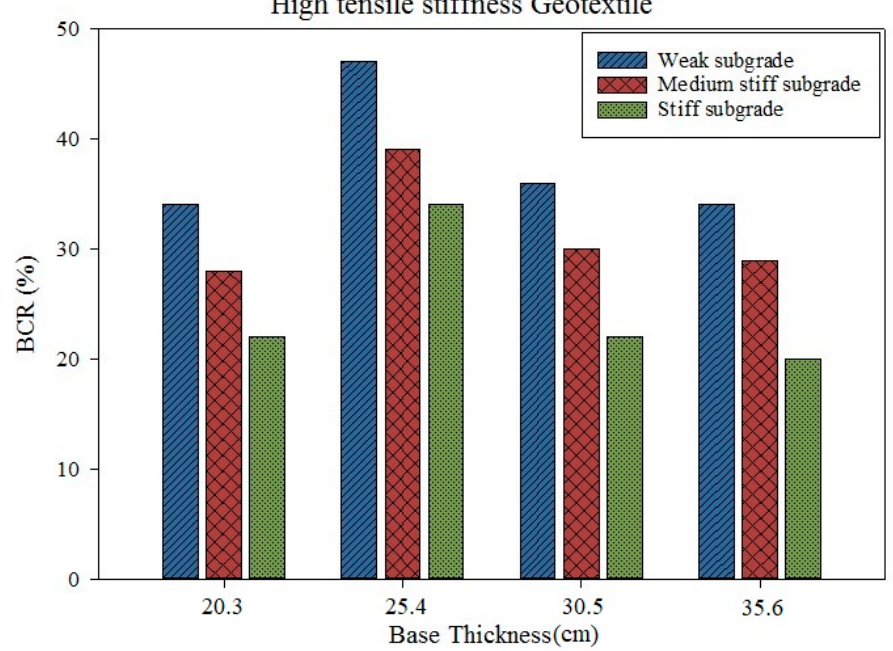
Figure 15. Changes in the BCR of the pavement reinforced with a high tensile stiffness geotextile for different subgrade stiffnesses. different subgrade